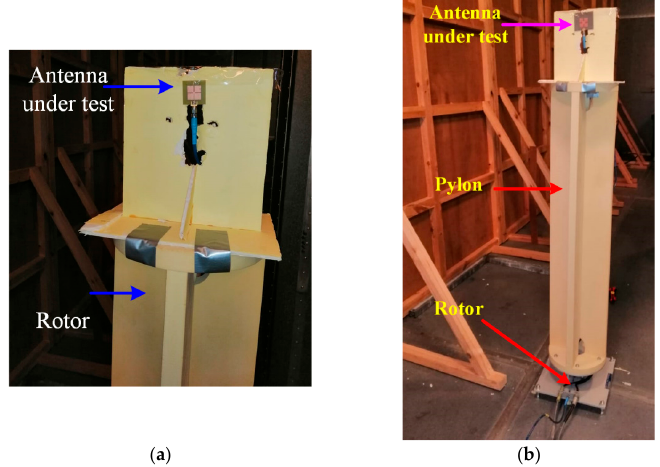
Figure 20. The measurement setup of the antenna radiation pattern.